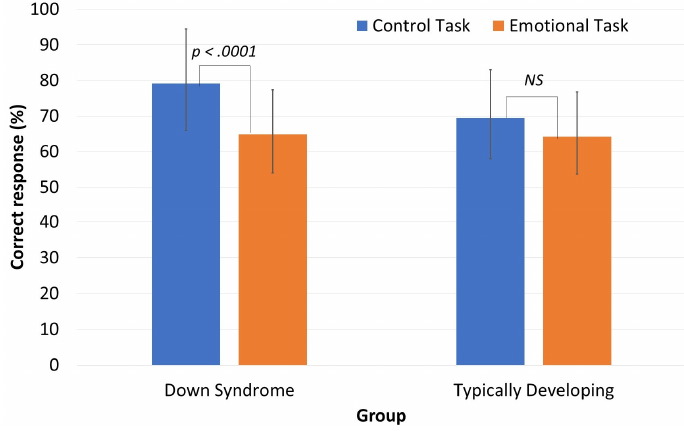
Figure 1. Mean percentage of correct responses in the experimental tasks for the two groups.